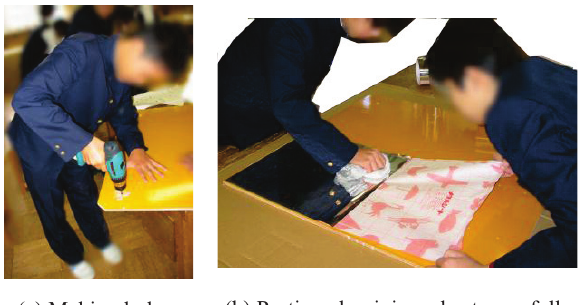
Ascending orbit (14 Nov. 2007)